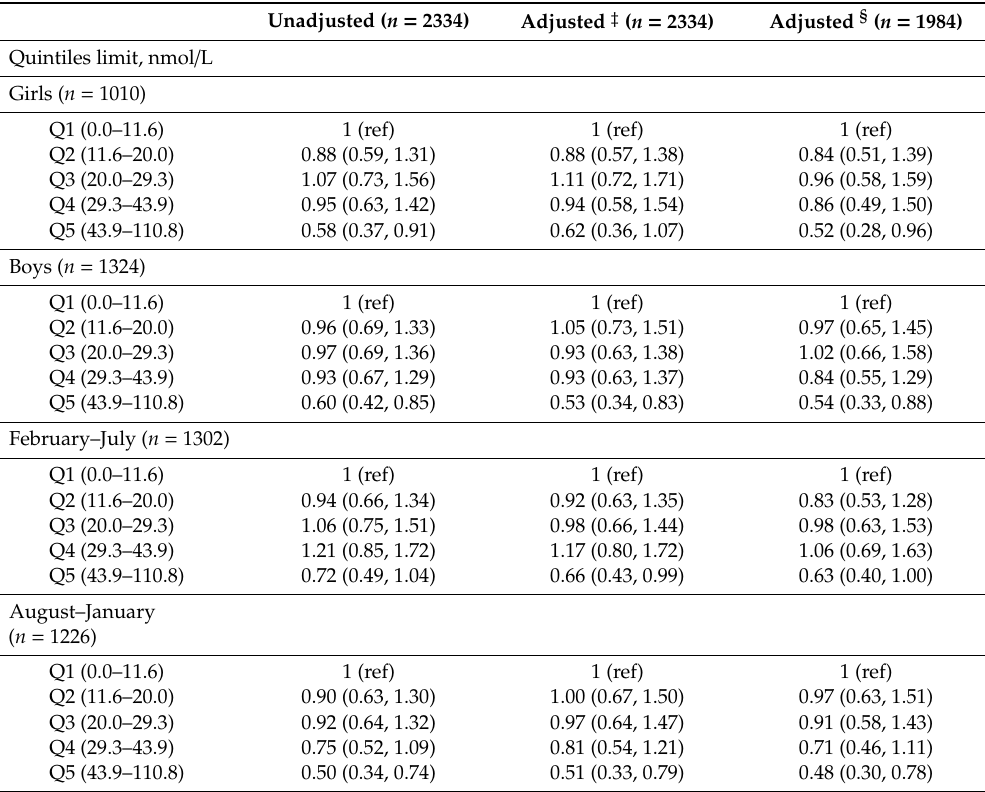
Table 3. Unadjusted and adjusted hazard ratio † (95% CI) of asthma among Danish children age 3–9 years according to quintiles of neonatal 25(OH)D 3 concentrations, stratified by sex and season of birth.